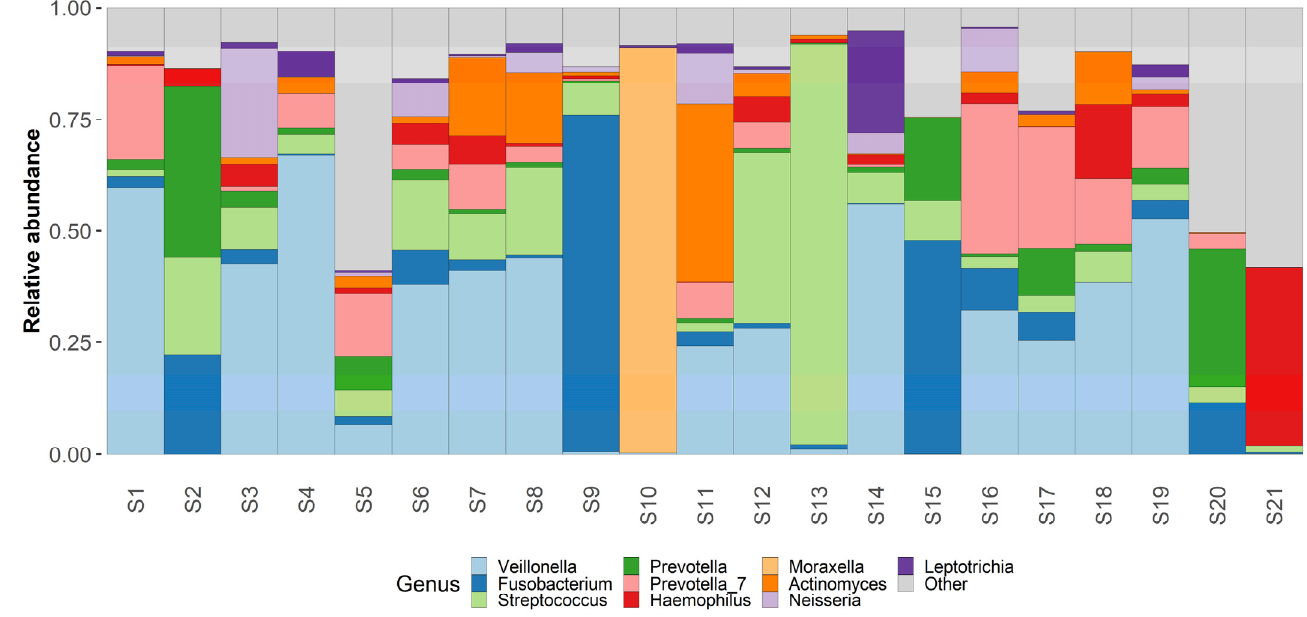
Figure 3. Genus level taxonomy. Taxaplot showing the relative abundances of most common genera within the samples.